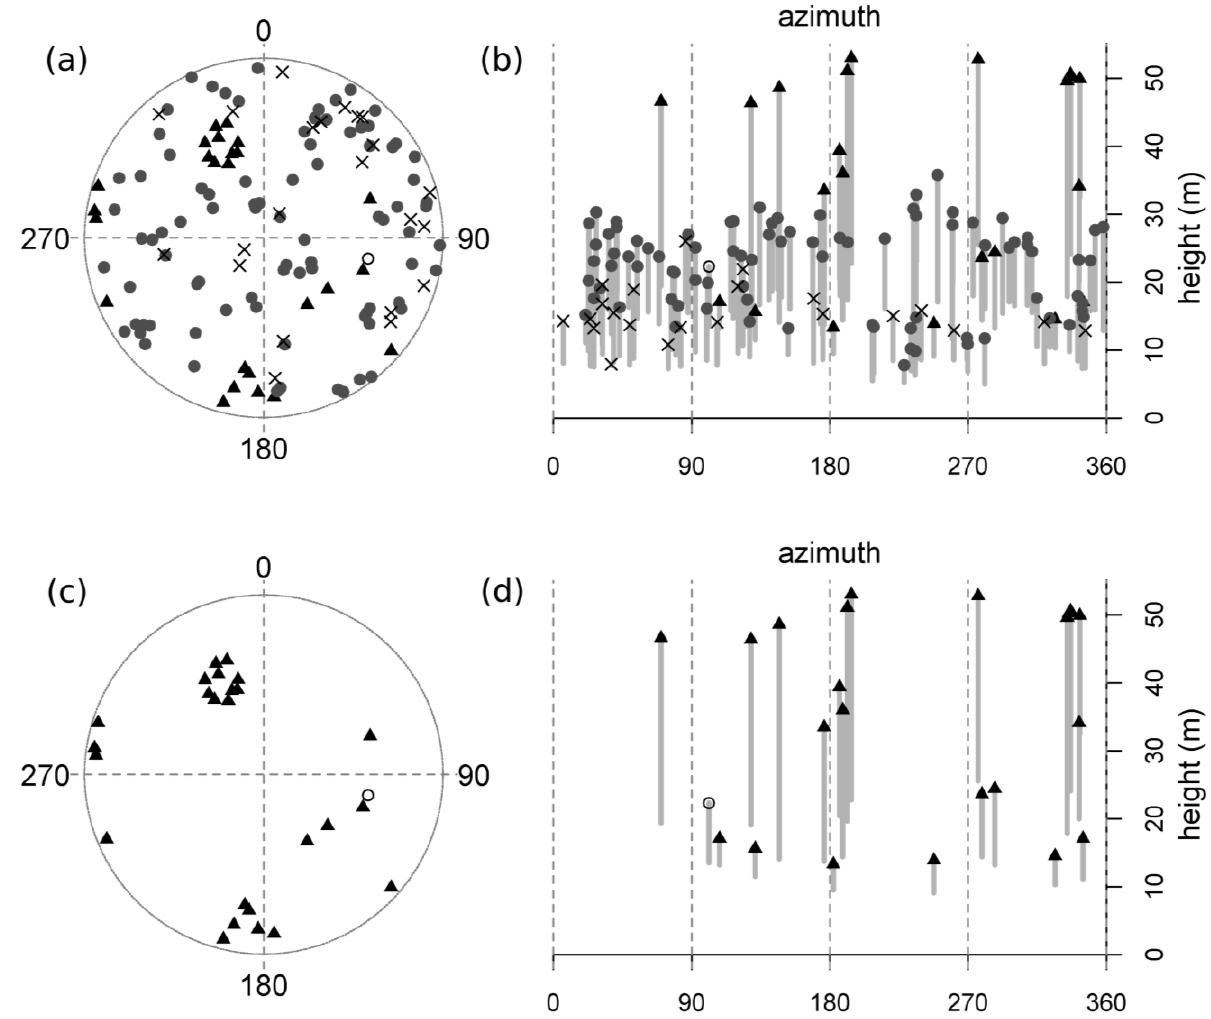
Figure 1. A representative healthy plot (MMWD-S7; see Table 1). Trees are mapped (a & c) and represented vertically (b & d; top height and height-to-live-crown are plotted against azimuth, thus “unrolling” the 360 degree view from plot center, and achieving a two-dimensional image by flattening all distances from plot center into a single plane). The top set of graphs (a & b) displays all trees, including reconstructed dead tanoaks, and the bottom set (c & d) illustrates this plot after the removal of all tanoaks (both living and dead). Symbols represent the following: “X”s = dead tanoak; gray circles = living tanoak; black triangles = redwood; open circles = hardwoods other than tanoak; no conifers other than redwood were present in this plot. Gray bars display the length of the live crown (the symbol at the top of each bar is the total tree height and the lower limit of each bar is the